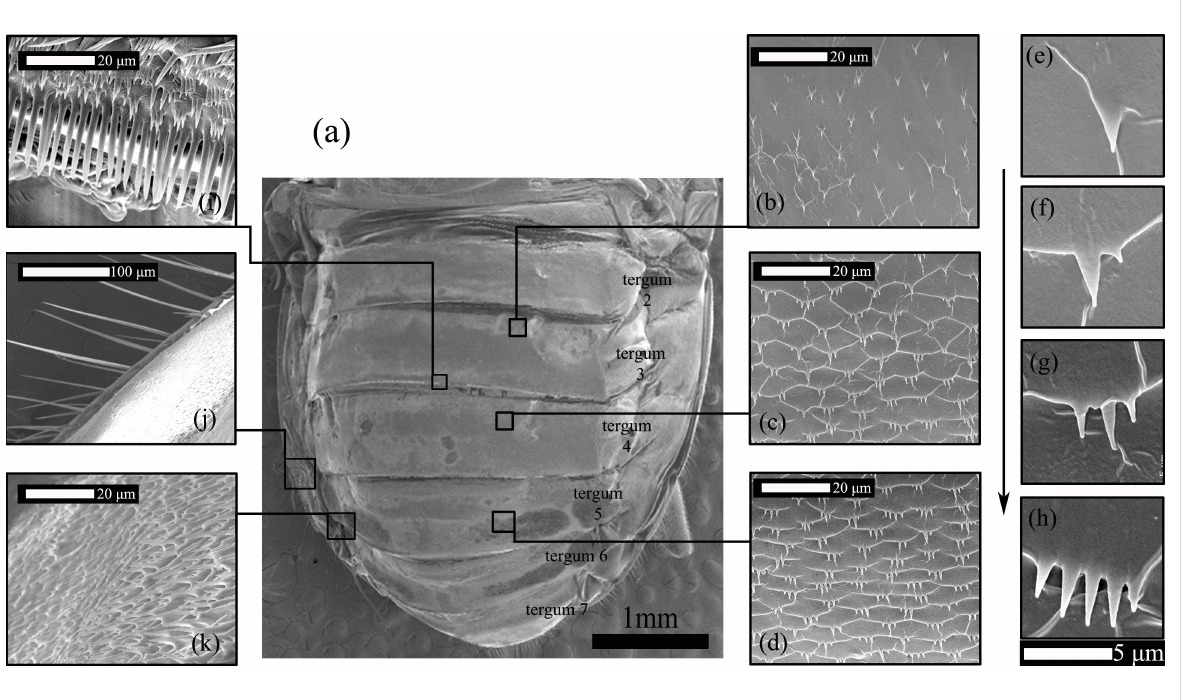
Figure 4: (a) SEM photograph of the abdominal terga of H. axyridis ; (b, c, d) the pattern of microtrichial arrangement on the middle of the abdomen; (j, k) the microtrichia on both sides of the abdomen; (j) the lateral margin; (k) part of the spicule patch; (i) part of the palisade fringe at the posterior margin of the tergum; (e, f, g, h) the number of microtrichia in each cluster gradually increases from single to multiple in the middle of the